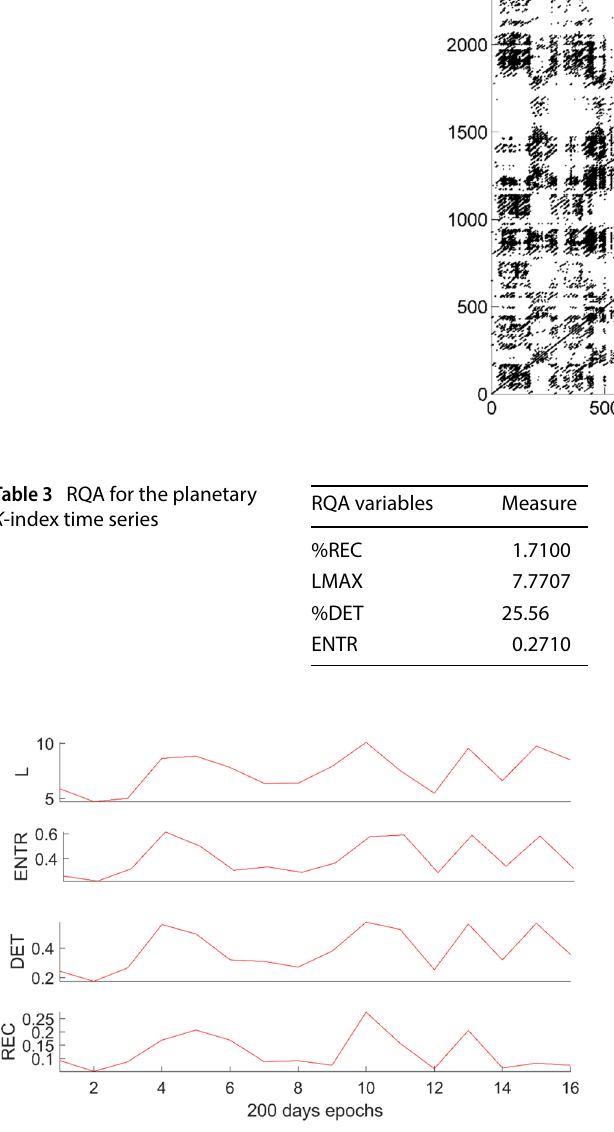
Fig. 9 The temporal evolution graph of REC, LMAX, DET and